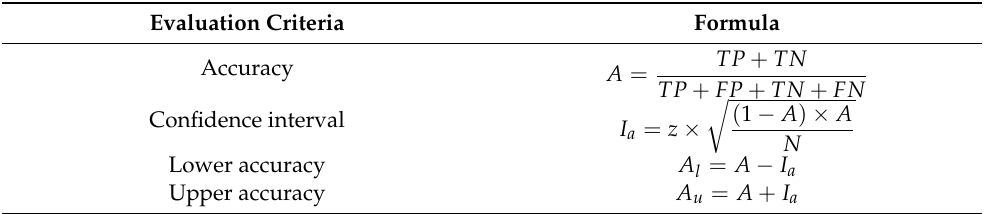
Table 8. Overview of evaluation criteria for IAA. z = 1.96 for 95% confidence interval and the number of samples N is 800, 400 and 400 for GIAA, LIAA and CIAA respectively. TP, FP, TN, FN are a number of images. Evaluation